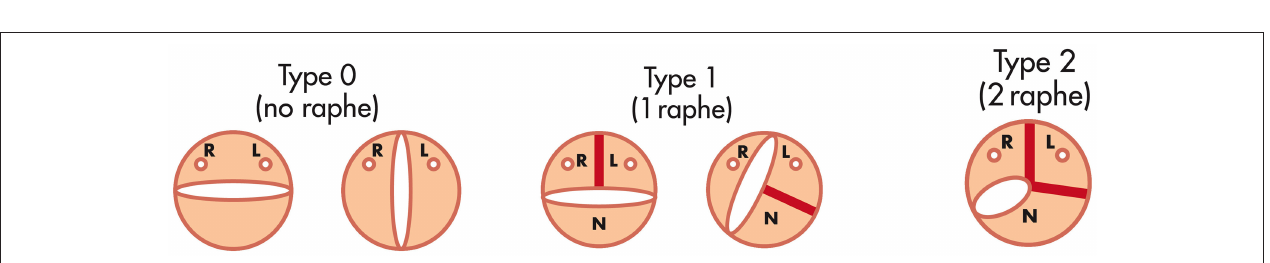
common in Asia, but not in North America or Europe.